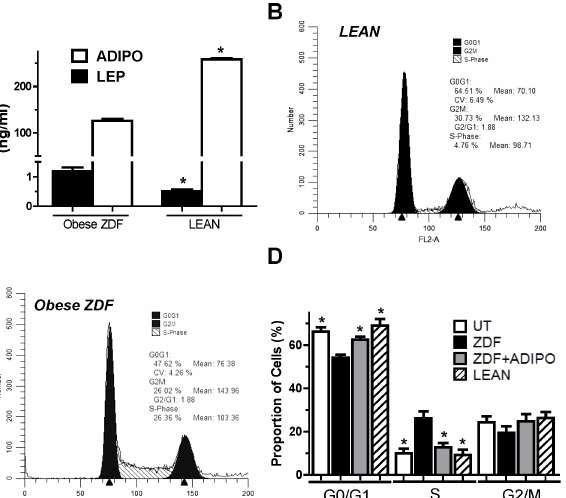
Fig 1. Co-cultured subcutaneous adipocytes elicit cell cycle changes in MCF7 cells. A: Graphical representation of ADIPO and LEP concentration (ng/ml) in media co-cultured with isolatedsubcutaneous adipocytesand MCF7 cells. B-C: Typical cell cycle profilesin MCF7 cells treated with lean Zucker adipocytes (4.4 × 10 6 ) and ZDF adipocytes(1.6 × 10 5 ). D: Graphical representation of multiplecell cycle profile experiments observingeffects of adipocyteco-culture with ZDF (closed bars), ZDF+ 9 nM ADIPO (grey bars) and lean Zucker (hatchedbars) in arrested MCF7 cells. One-way ANOVAs showedsignificantmain effects for all experiments (p < 0.05). * denotessignificantly different from ZDF (p < 0.05)as determined by Tukey’s post-hoc tests (n =